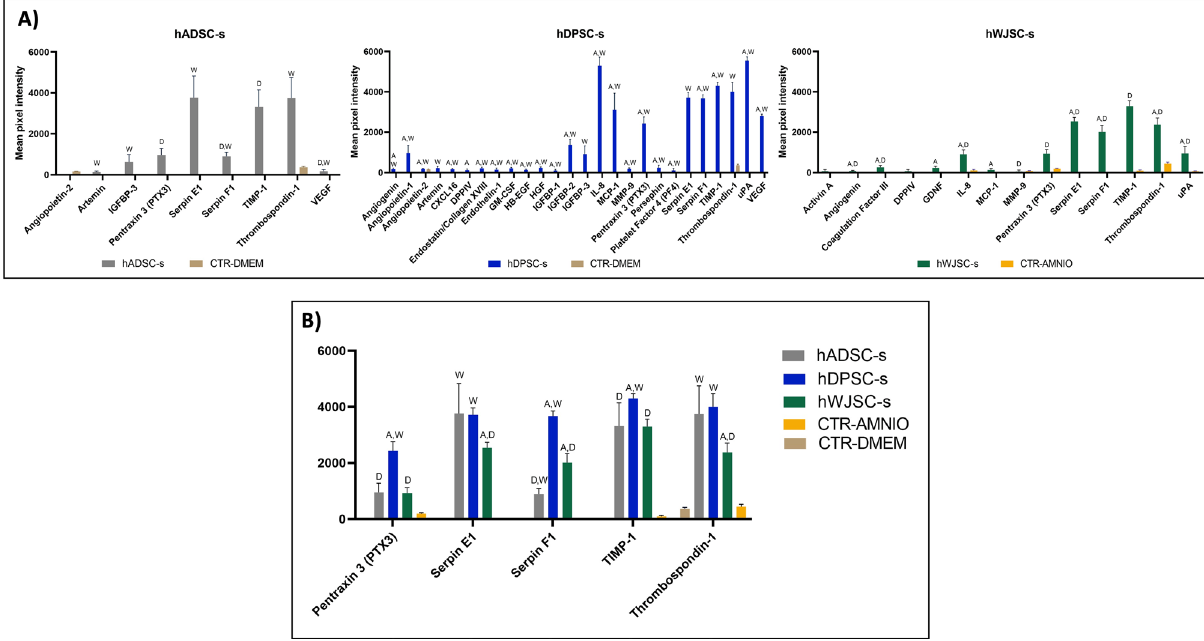
Figure 1. Protein analysis of each type of secretome. Values correspond to mean pixel intensity ± standard deviation for each type of secretome. hADSC-s human adipose-derived MSC secretome, hDPSC-s human dental pulp MSC secretome, hWJSC-s Wharton’s jelly MSC secretome. Statistically significant differences compared to hADSC-s are labeled A, differences compared to hDPSC-s are labeled D, and differences compared to hWJSC-s are labeled